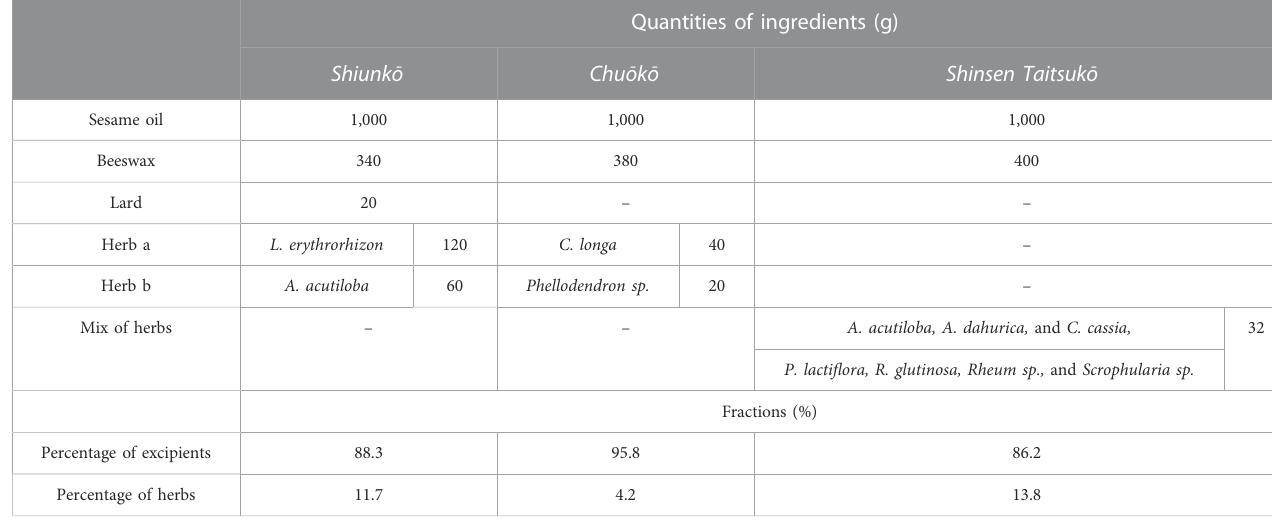
TABLE 3 Ingredients in Kampo ointments and corresponding quantities and fractions for excipients and herbs.